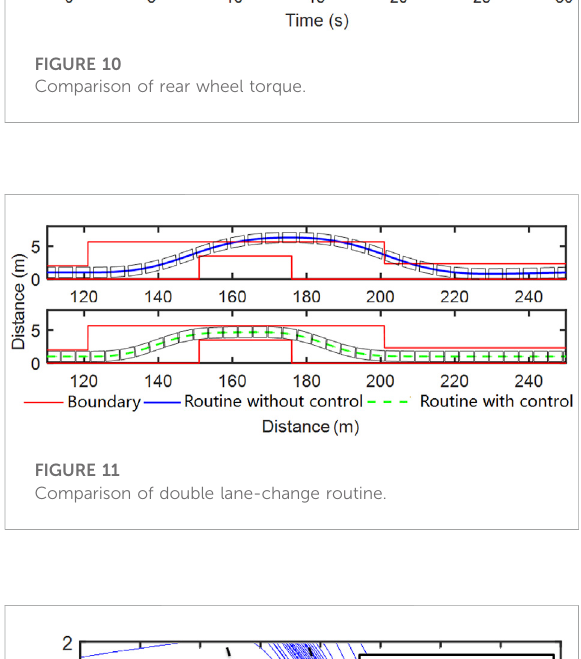
FIGURE 10 Comparison of rear wheel torque.